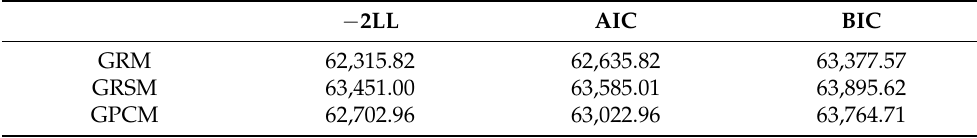
Table 3. The relative model-fit results of GRM, GRSM, and